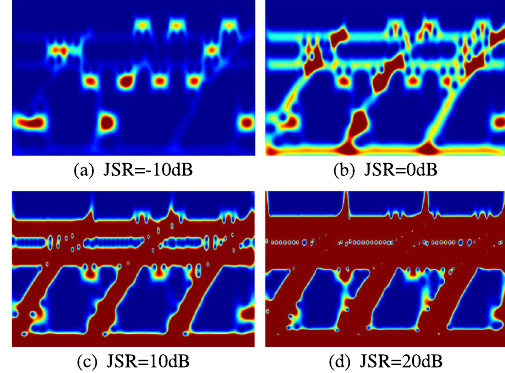
Fig. 7 Spectrogram images of interference signals at different